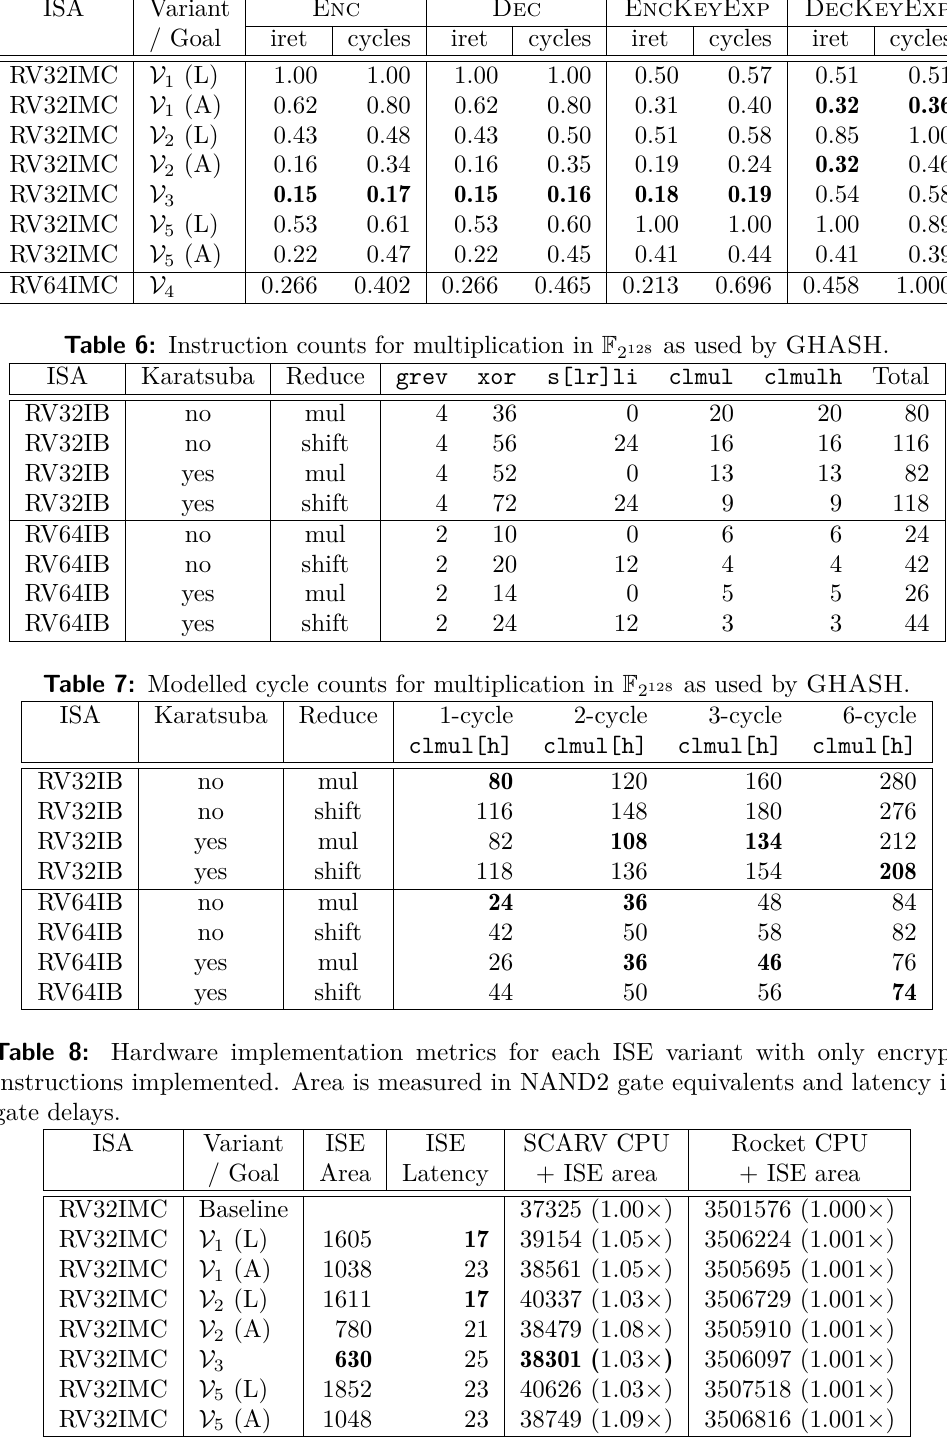
Table 5: Comparison of performance/area product. Each value is normalised to the largest product per column. The RV64IMC row is not normalised as there is no comparison point.